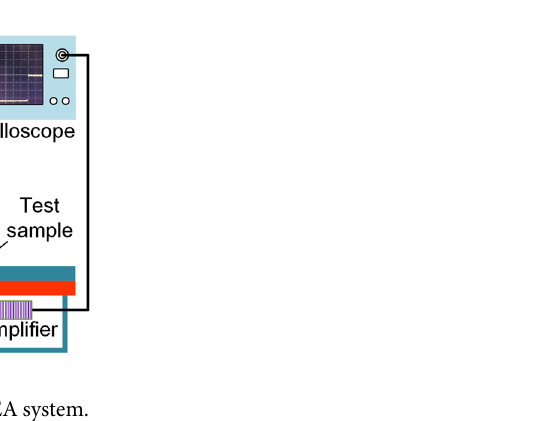
Figure 11. The schematic illustration of the PEA